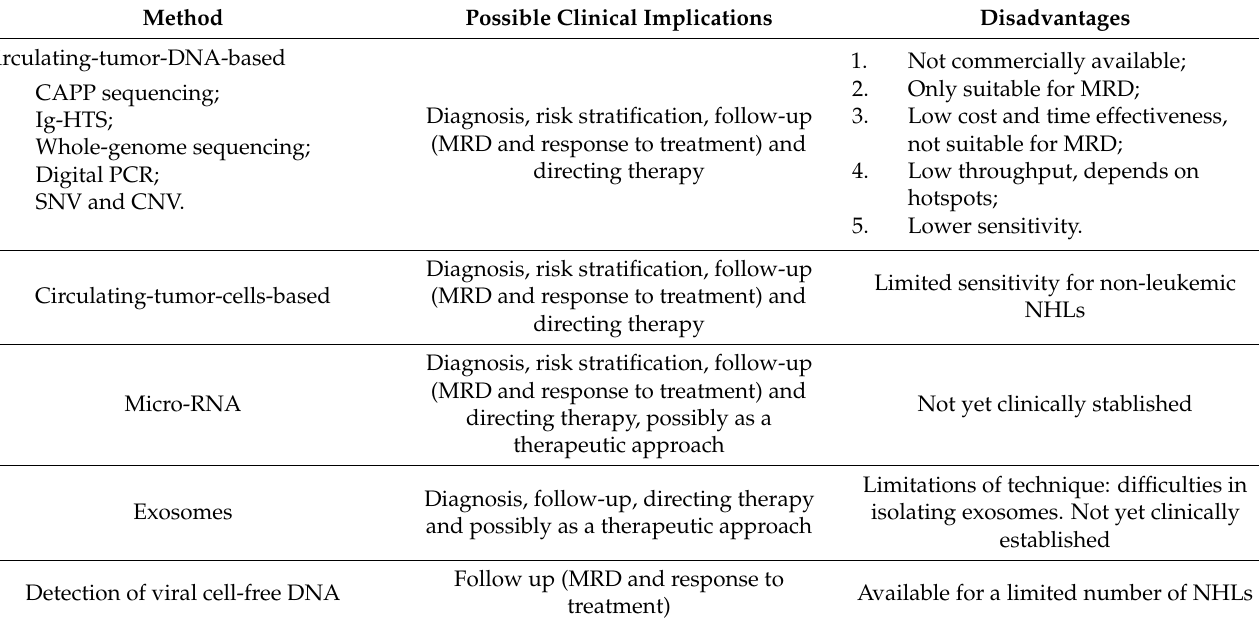
Table 2. Non-invasive molecular methods for